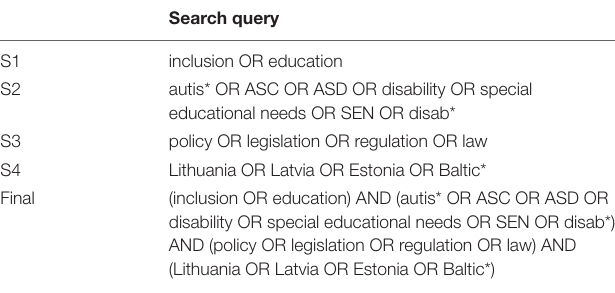
TABLE 2 | The build-up of the final search query for academic